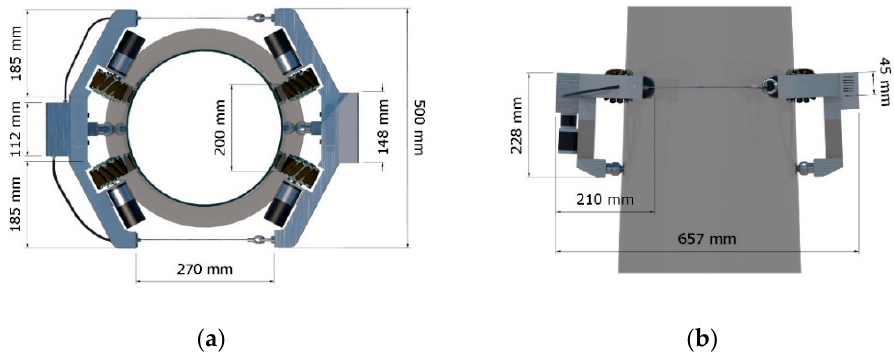
Figure 4. Climbing Robot Dimensions: ( a ) top view; ( b ) side view.